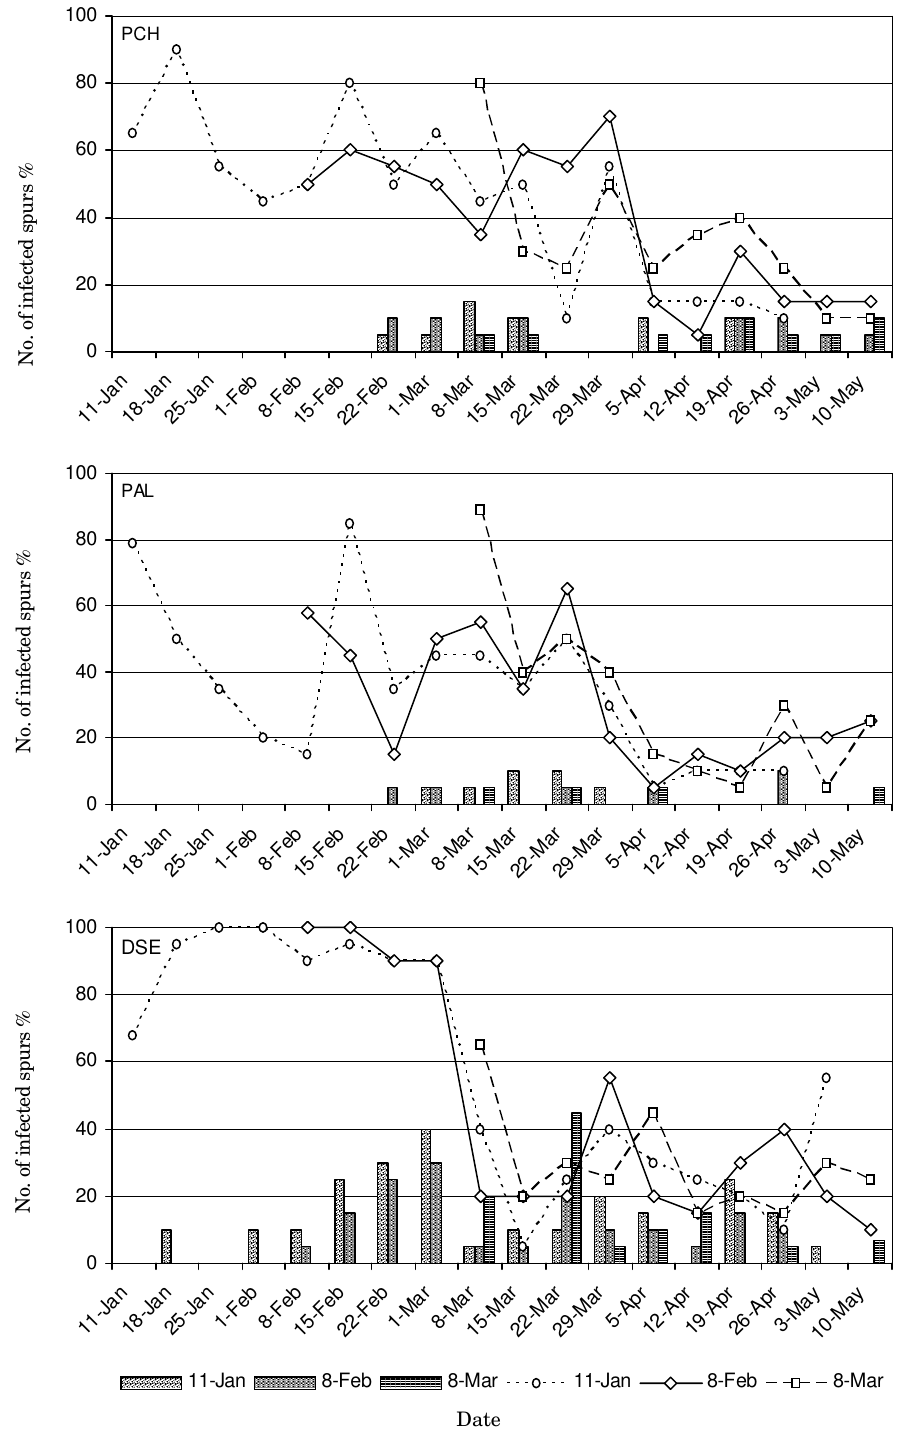
Fig. 3. Weekly infection percentages of spurs pruned in January, February and March and arti fi cially inoculated (dotted lines) or naturally infected (bars) with Phaeomoniella chlamydospora (PCH), Phaeoacremonium aleophilum (PAL) or Diplodia seriata (DSE) in